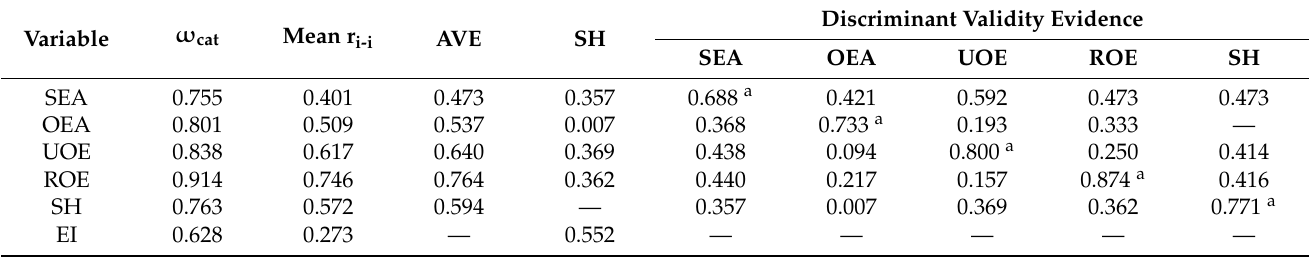
Table 4. Reliability, mean inter-item correlation, and convergent and discriminant validity evidence.